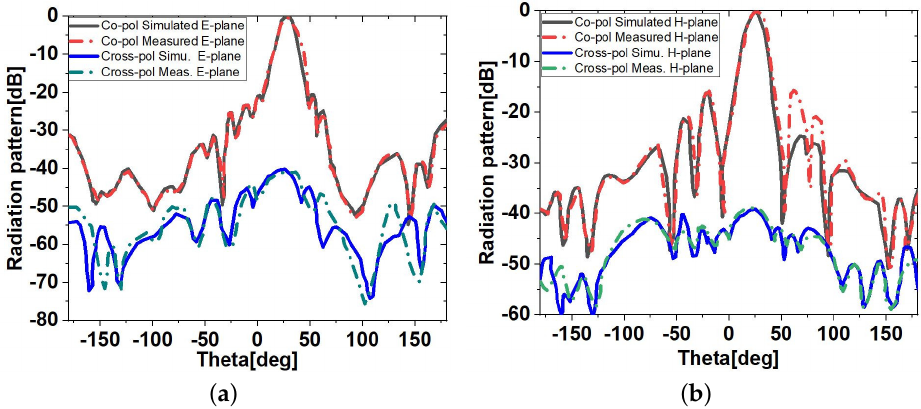
Figure 11. Measured and simulated copolar and crosspolar ( a ) E -plane and ( b ) H -plane radiation patterns at 62.5